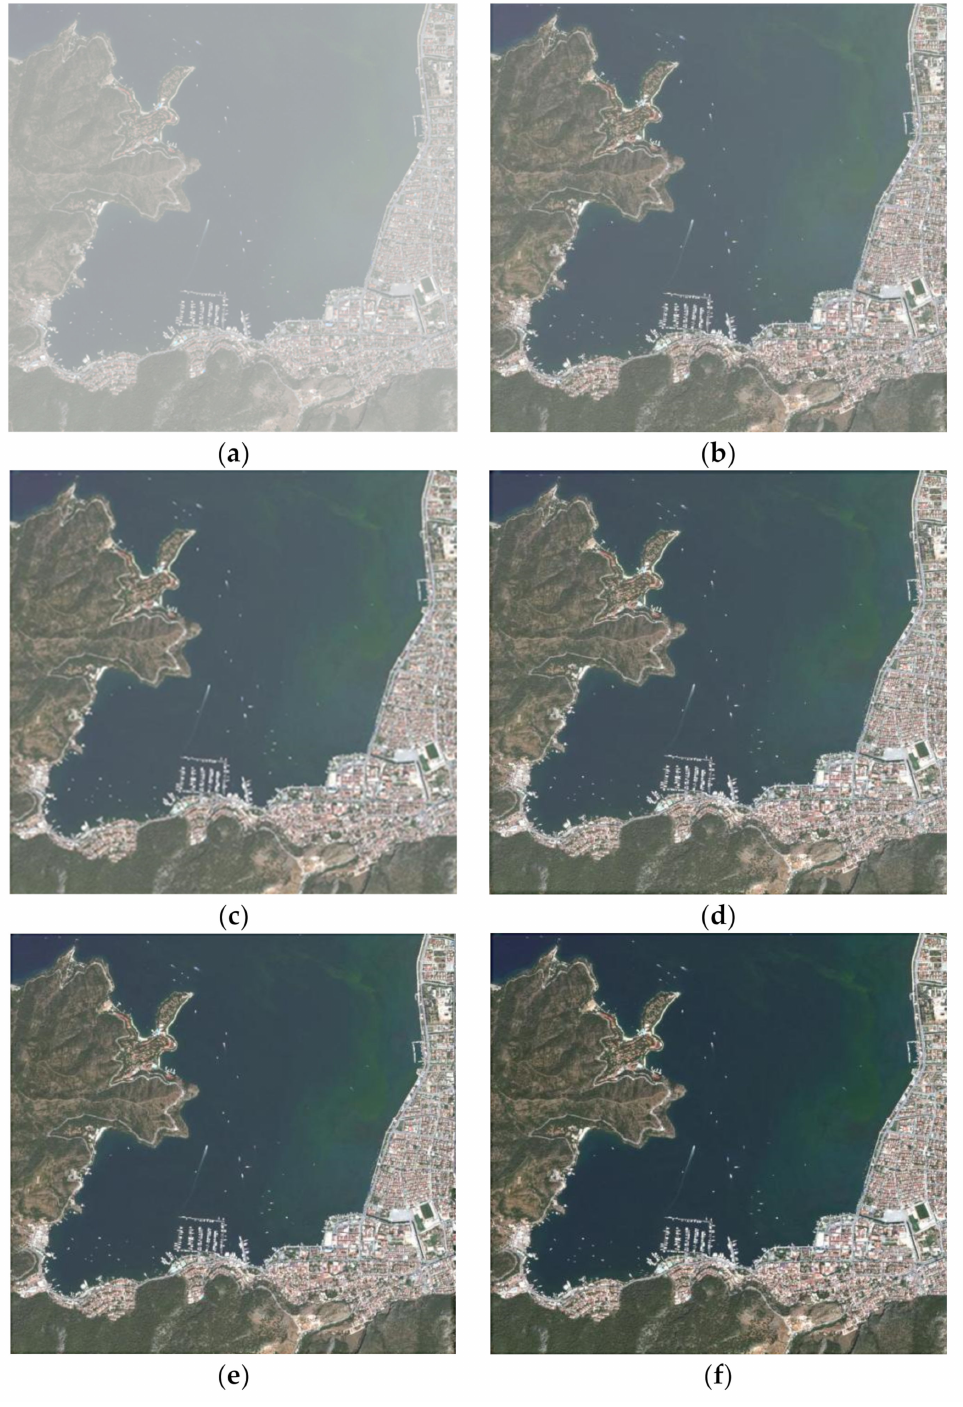
Figure 8. ( a ) Image of foggy coastal countryside; ( b ) ω = 0.65; ( c ) ω = 0.75; ( d ) ω = 0.85; ( e ) ω = 0.95; ( f ) ω =